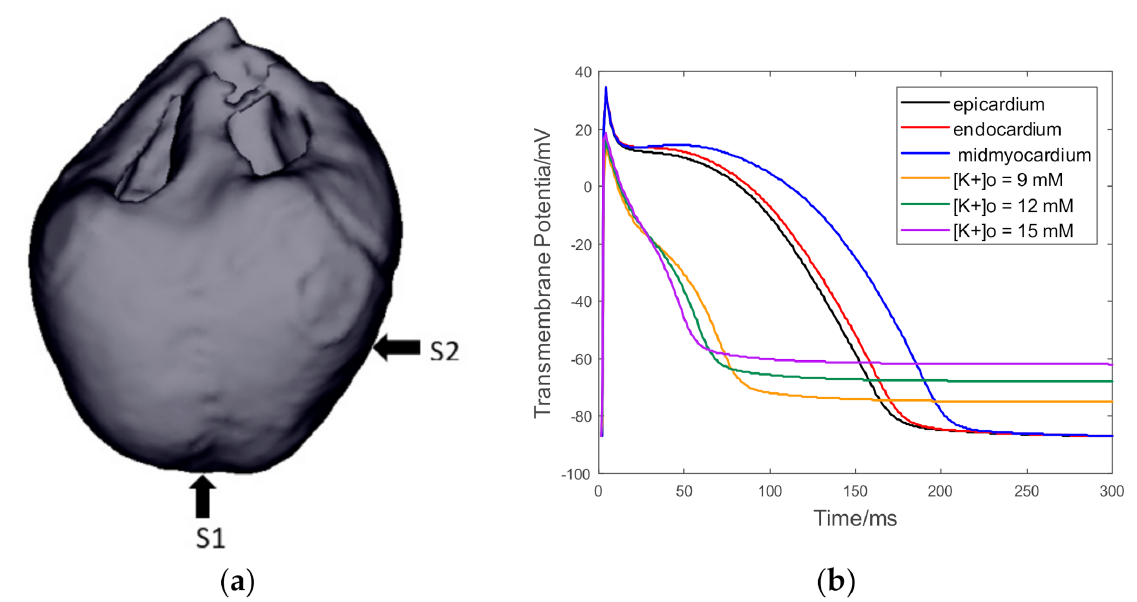
Figure 2. ( a ) The position where S1 and S2 stimulation are applied; ( b ). Simulated action potentials under steady state for the endocardium cells, epicardium cells, midmyocardium cells and ischemic cardiomyocytes in the ICZ at three extracellular potassium